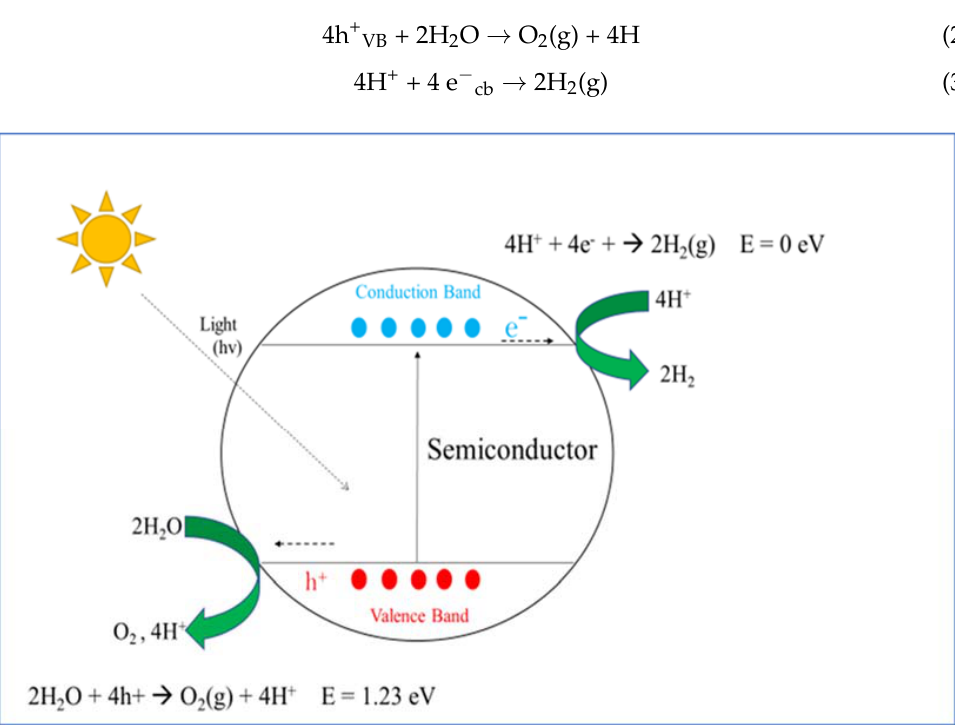
Figure 10. Schematic diagram of photocatalytic water splitting using a semiconductor.